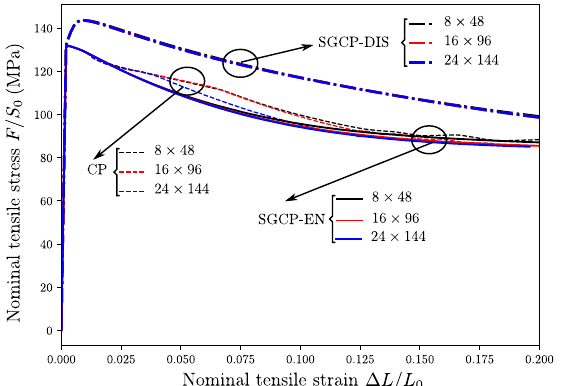
Figure 11. Uniaxial tension results obtained using conventional CP (CP: l en = l dis = 0), SGCP including only higher-order energetic effects (SGCP-EN: l en / W = 0.25, l dis = 0) and SGCP including only higher-order dissipative effects (SGCP-DIS: l en = 0, l dis / W = 0.25) for different meshes, with S ξ 0 = 60.84 MPa and H ξ =